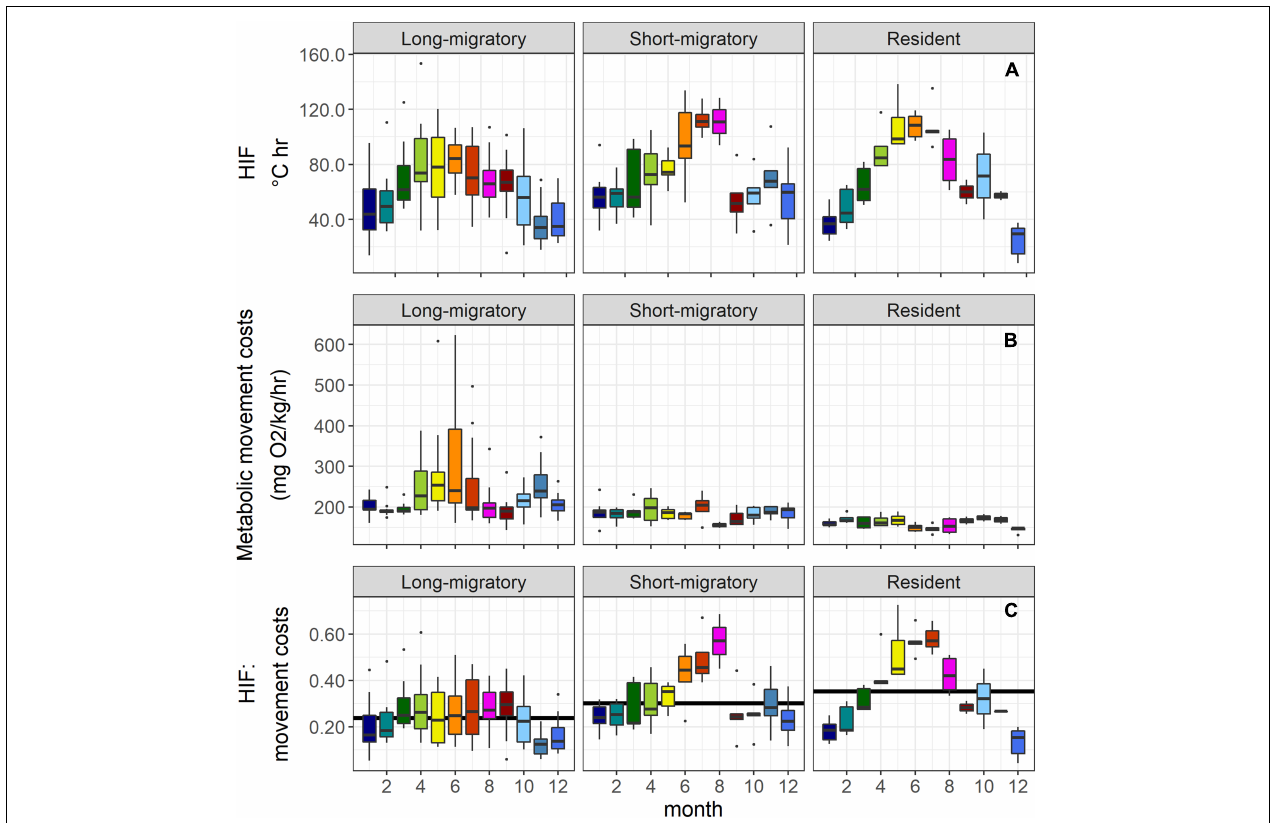
FIGURE 7 | (A) Mean monthly HIF, (B) mean monthly movement costs based on water temperature and swimming speed, and (C) HIF-cost ratio, normalized against the maximum value. Annual mean values of (C) are shown as solid black lines. Tagged fish are split into “long-migratory” fish, “short-migratory” fish, and “resident” fish (see Table 1 and Figure 1 ). Note that fish at large for more than one migration year always showed the same migratory